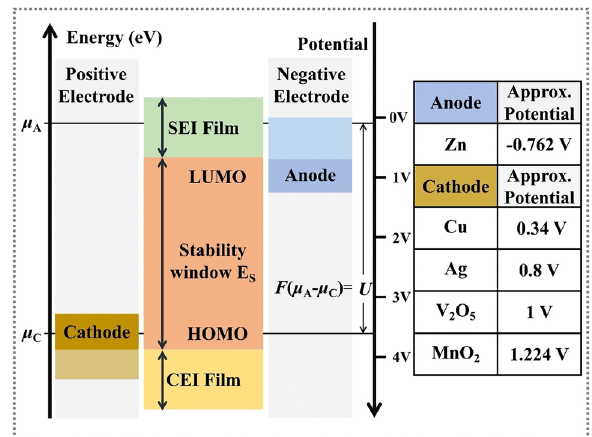
Fig. 4 Schematic diagram of energy band of